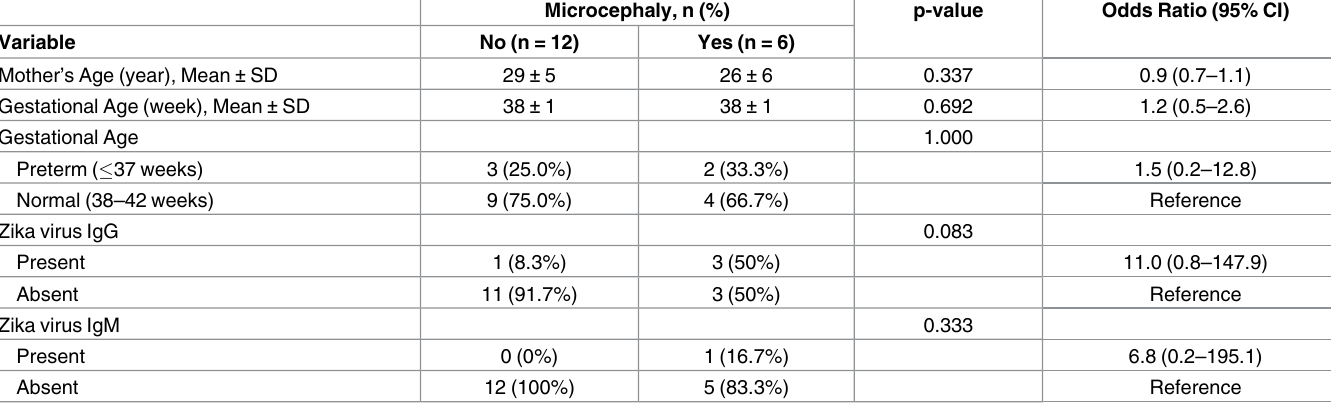
Column percentage. CI = confidence interval. SD = standard deviation. Note: p-value was obtained by Fisher’s exact test for categorical variable or two sample t test for continuous variable. A correction of 0.5 was used to compute odds ratio in every cell that contains a